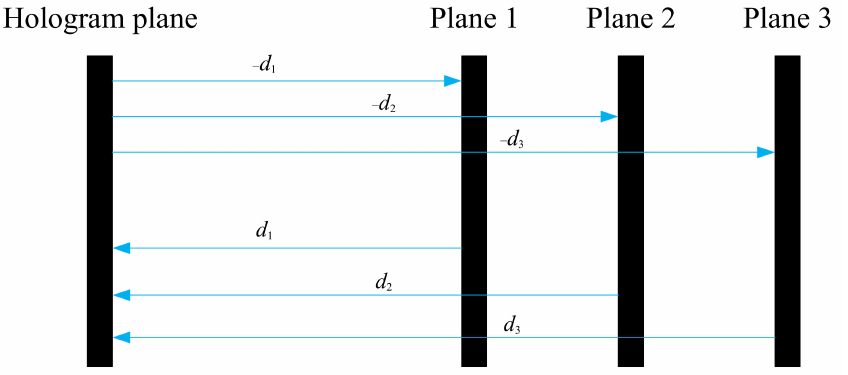
Figure 1. The propagation diagram of the 3D iterative